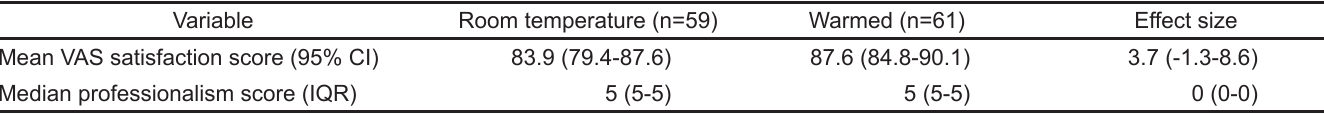
Table 2. Outcomes of study examining impact of heated vs. room-temperature ultrasound gel on patient satisfaction.